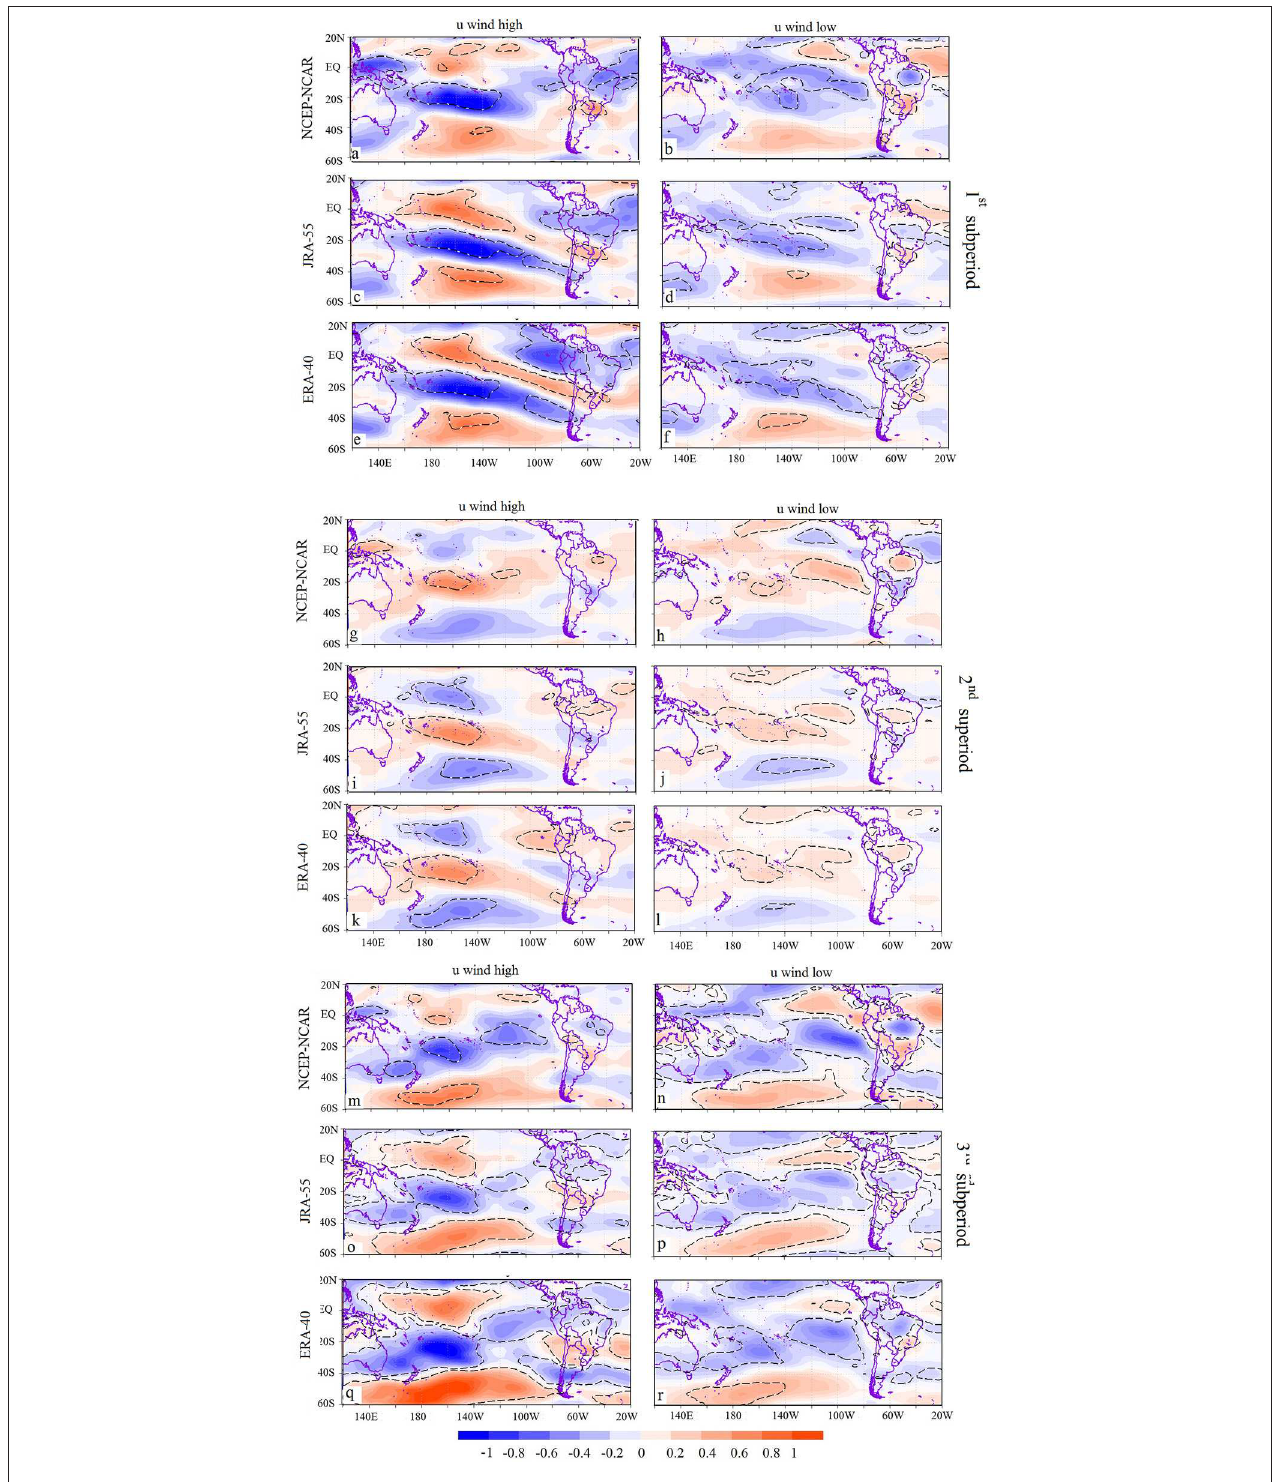
FIGURE 5 | Zonal wind anomaly at high levels (500–250 hPa) for (a) NCEP-NCAR, (c) JRA-55, and (e) ERA-40 reanalysis for the 1st subperiod. (b,d,f) The same as (a,c,e) but for low levels (850–600 hPa). (g,i,k) The same as (a,c,e) and (h,j,l) the same as (b,d,f) but for the 2nd subperiod. (m,o,q) The same as (a,c,e) and (n,p,r) the same as (b,d,f) but for the 3rd subperiod. JRA-55 u-wind anomaly values are multiplied by 2. Statistic significant values for α = 0.05 ( t -Student) are surrounded by dashed lines.